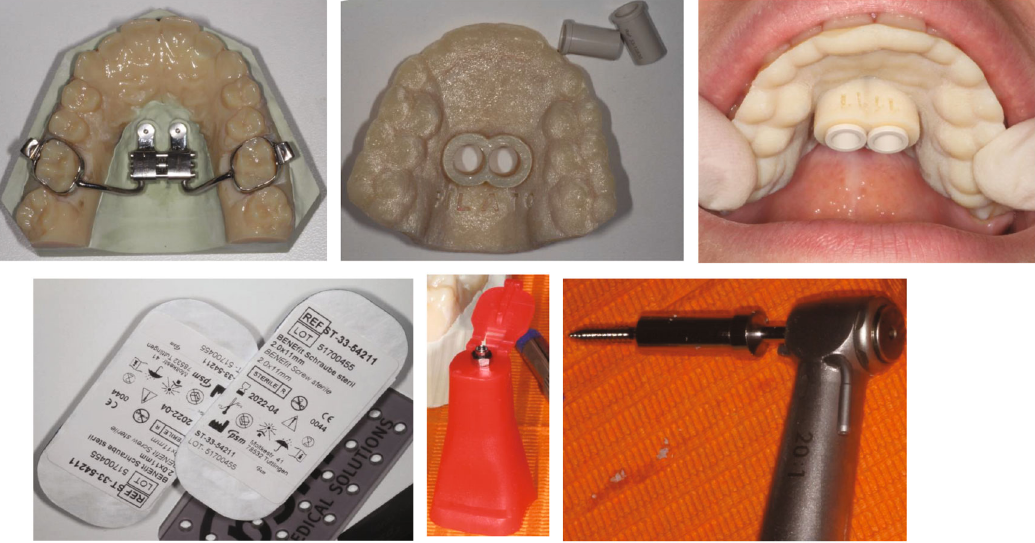
Figure 7: Operative sequence.